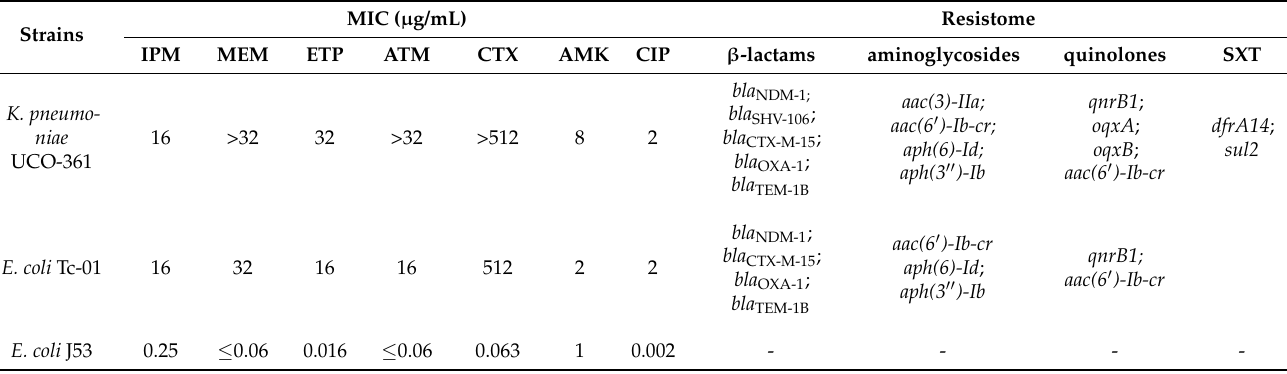
Table 1. Susceptibility profile and resistome of K. pneumoniae UCO-361 and transconjugant E. coli Tc-01